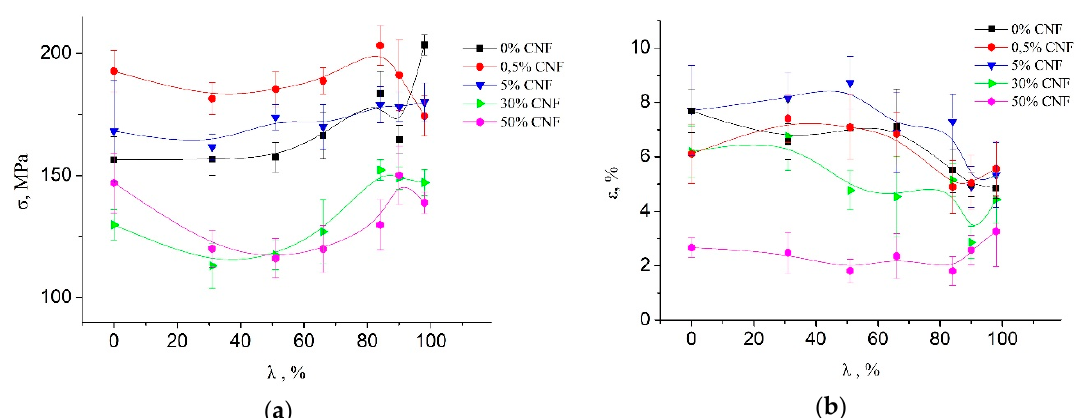
Figure 1. ( a ) Dependence of fiber tensile strength on the factor of orientation drawing; ( b ) dependence of fiber elongation at break on the factor of orientation drawing.